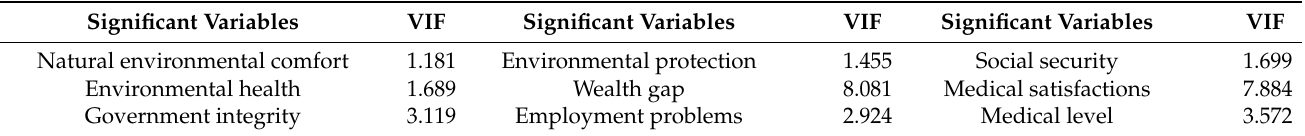
Table 6. Collinearity test for significant